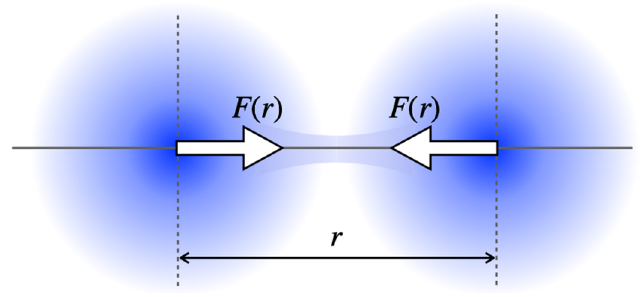
Figure 1 . Effective force between blobs in the large D effective